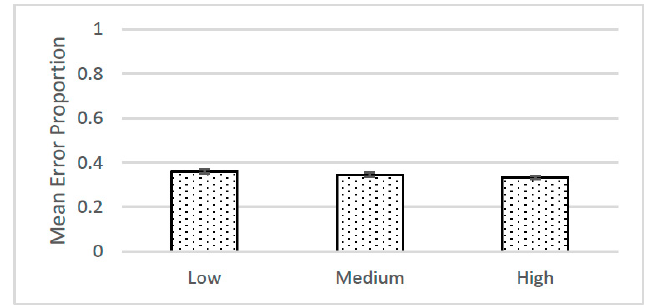
Figure 1. Means and standard errors for proportions of errors committed on the Stroop task for the low, medium, and high contingency conditions. low, medium, and high contingency